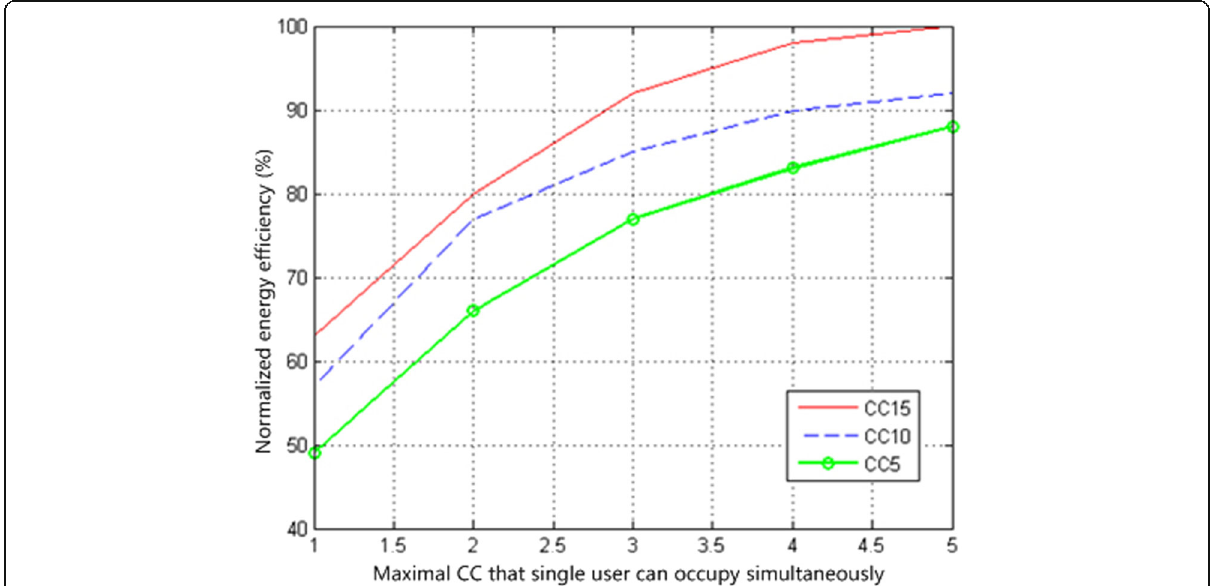
Fig. 3 System energy efficiency v.s. maximal CC that single user can occupy